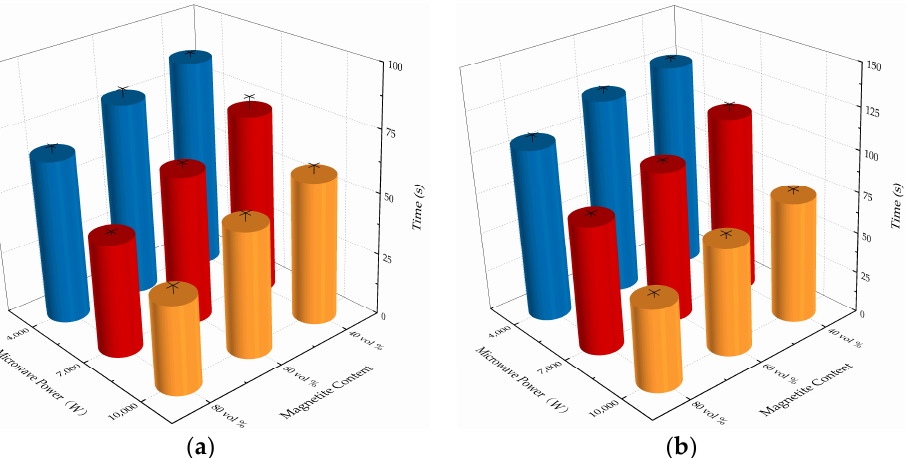
and Figure 12. (Figure 10: x-axis: magnetite content; y-axis: microwave power; z-axis: (Figure 10: x-axis: magnetite content; y-axis: microwave power; z-axis: mean value of time). mean value of time).